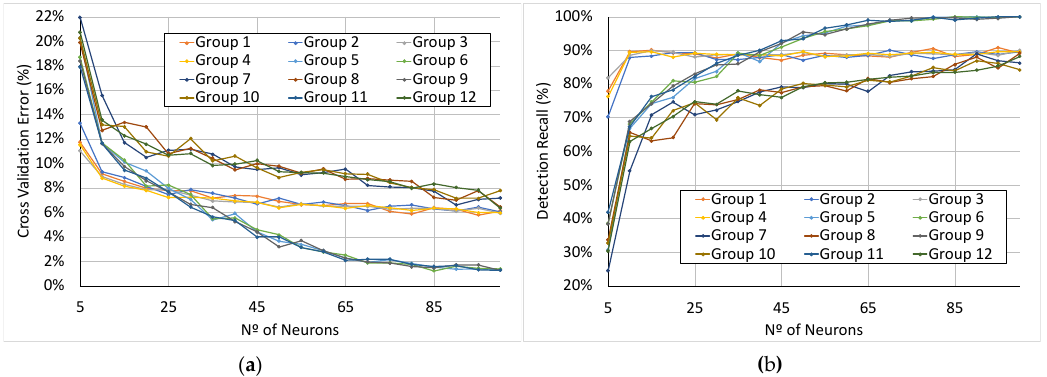
Figure 13. Artificial Neural Network (ANN) cross validation results for different groups of features: ( a ) error; ( b ) detection recall.